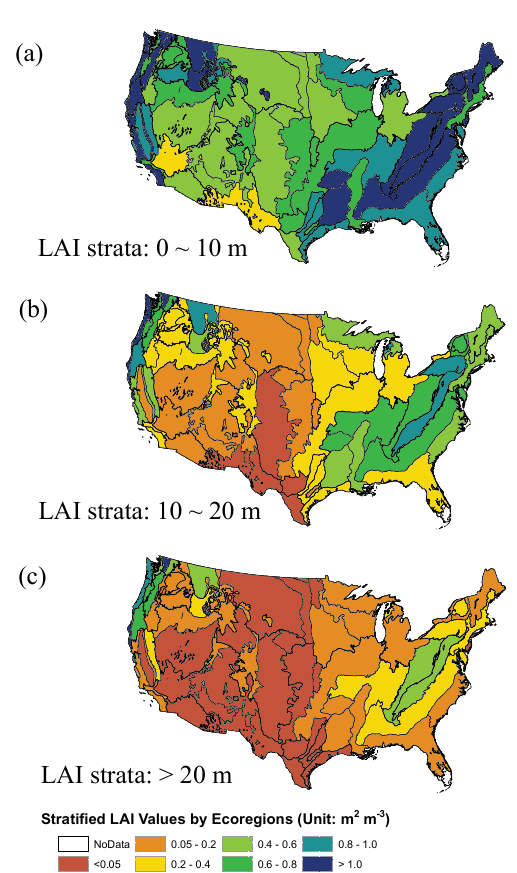
Figure 6. LAI strata distributions by WWF ecoregion. Despite sim- ilar total LAI values, the southeastern forests show different LAI values at stratified height